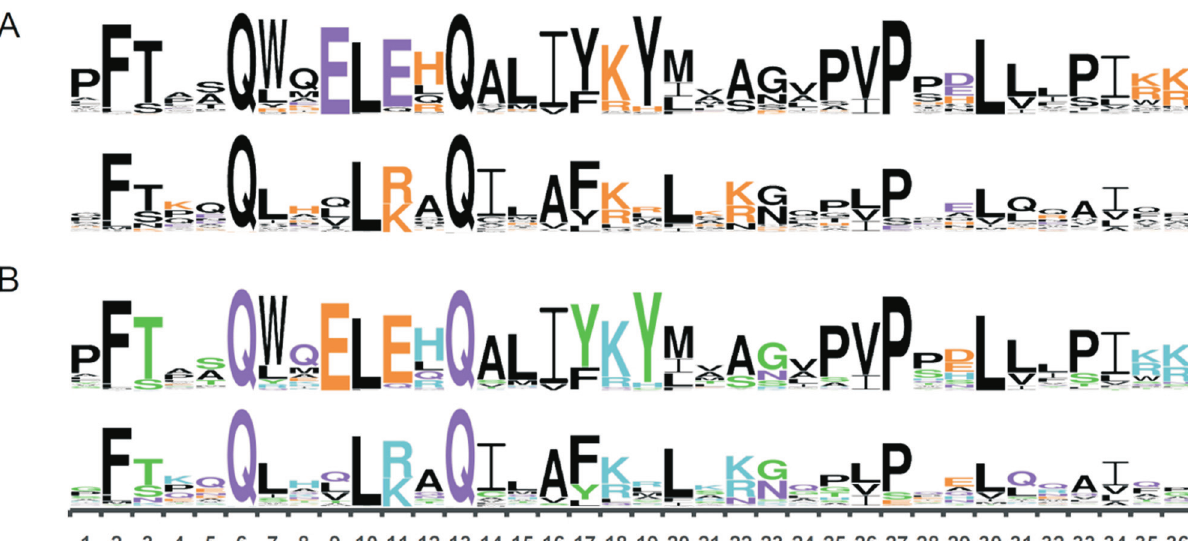
Figure3 -QLQpropertiesinSNF2andGRF.(A)LogosrepresentingthechargeoftheaminoacidsfromtheQLQdomainpresentinGRF(top)andSNF2 (bottom). Negative residues in purple and positive in orange. (B) Logos representing chemical properties of the amino acids from QLQ domain of GRF (top) and SNF2 (bottom). Basic residues in blue, acidic in orange, neutral in purple, polar in green, and hydrophobic in black. Protein sequences corre- sponding to the QLQ domain from SNF2 and GRFs were used separately to construct the diagrams in WebLogo3.